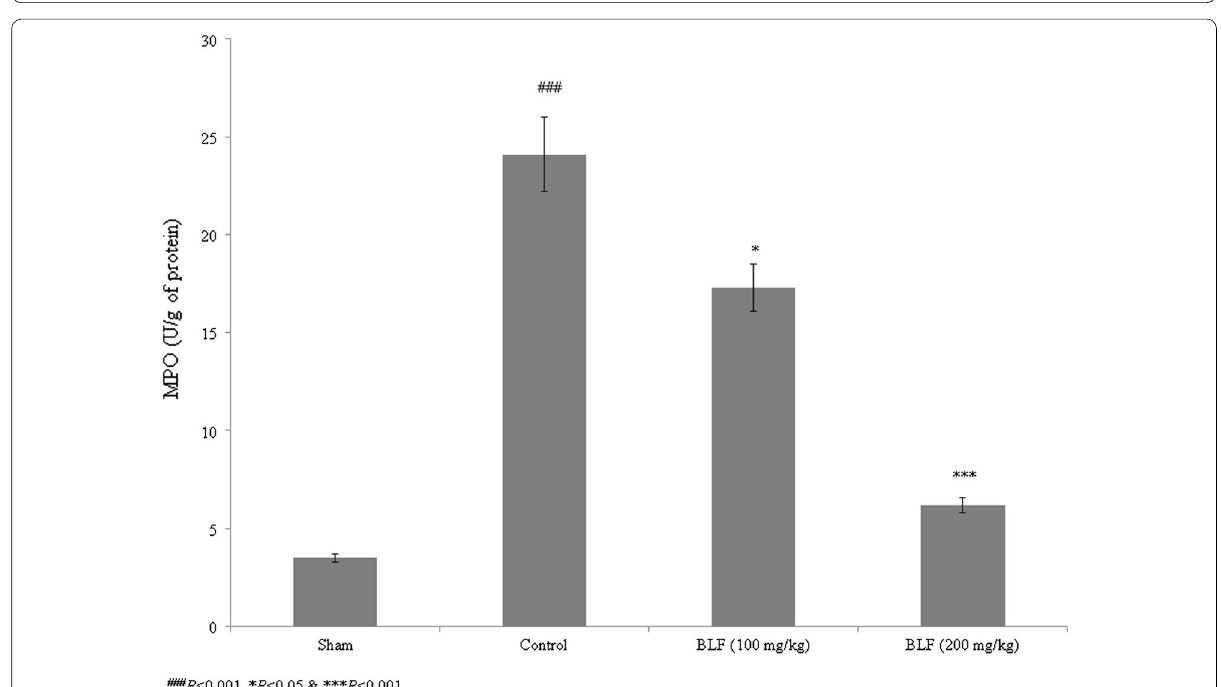
Fig. 7 BLF reduces myeloperoxidase (MPO) activity in ALI-induced male albino rats. Rats were given BLF for 30 consecutive days through oral gavage. ### P < 0.001 compared to the sham group; * P < 0.05 and *** P < 0.001 compared to control